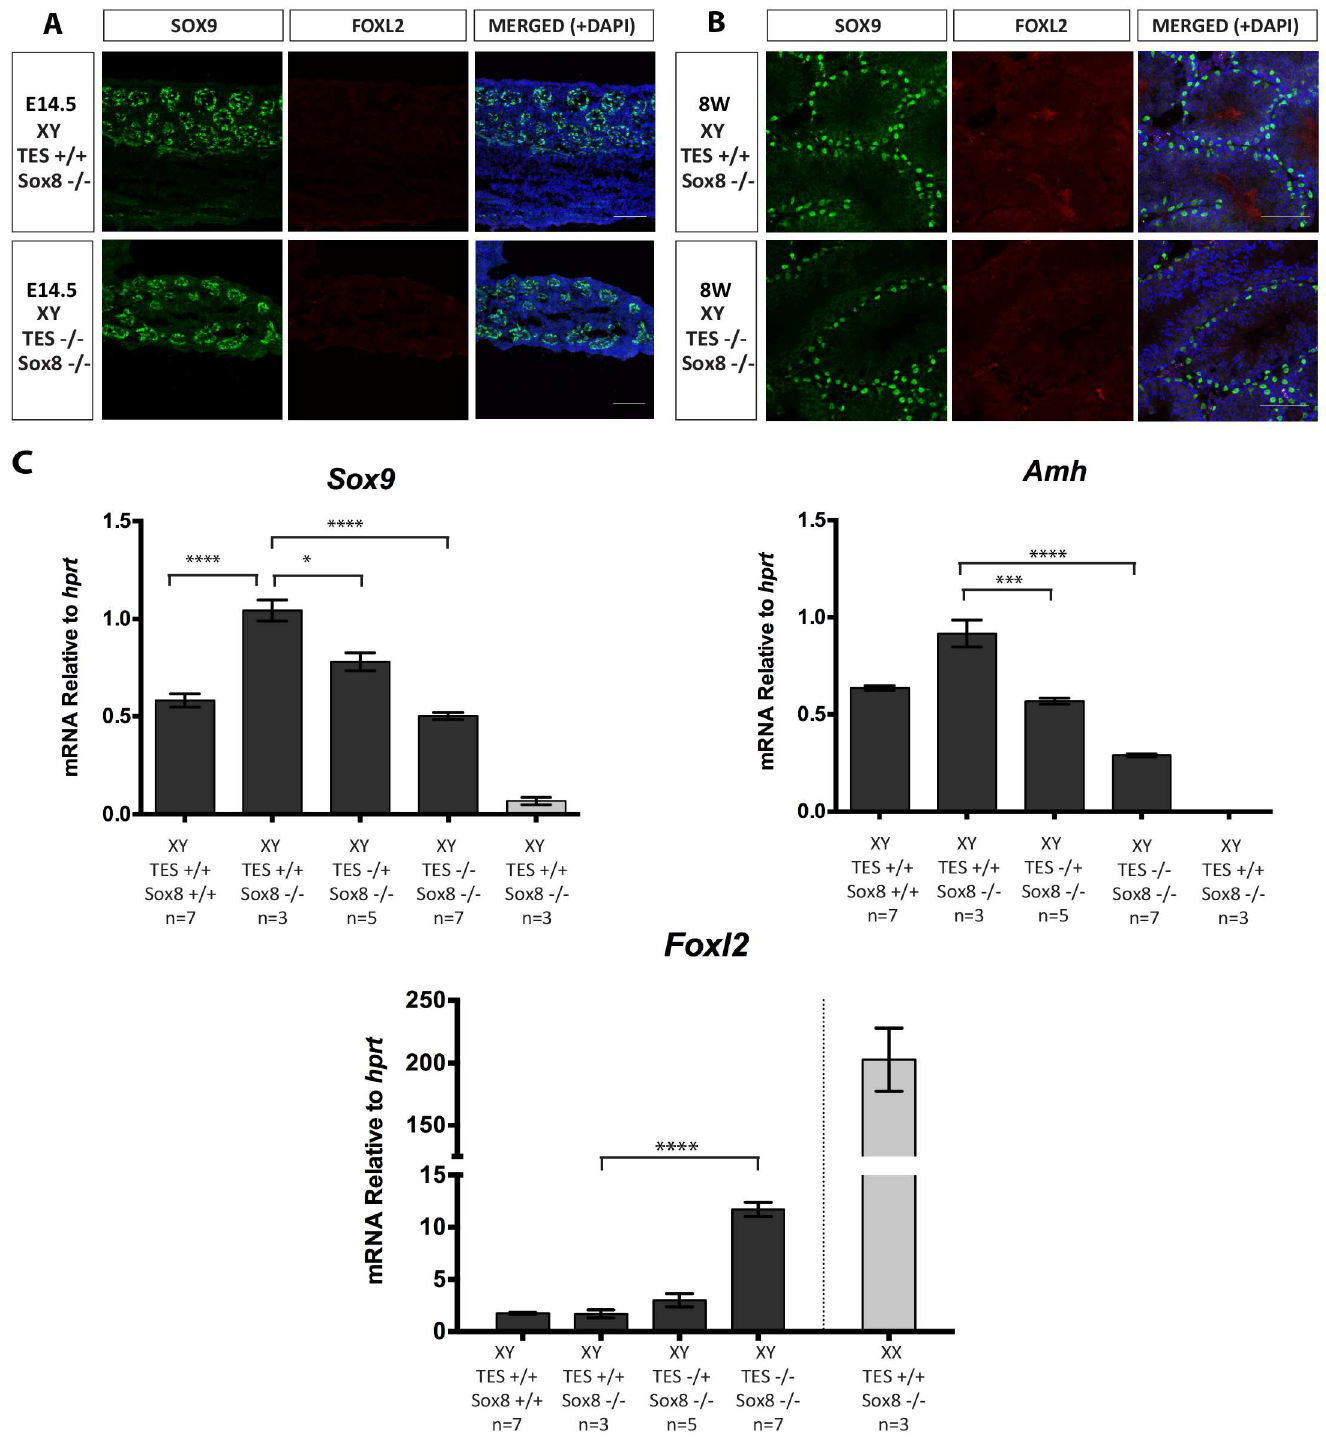
Fig 5. Immunofluorescenceand real-time quantitative RT-PCR analysis of mice carrying TES deletion on Sox8 -null background. (A) Immunostainingof 14.5 dpc XY testis of wild type and TES -/- embryoson a Sox8 -nullbackground. (B) Immunostaining of 8 week-oldXY testes of wild type and TES -/- mice on a Sox8 -null background. Testes were stainedfor SOX9 (green), FOXL2 (red) and DAPI (blue). (C) Gene expressionin XY TES deletedgonadswith Sox8 -null background at 14.5 dpc. Data are presentedas mean 2 - ΔΔ Ct values normalizedto Hprt . Samplesize represents numberof individualsand is indicatedbeloweach genotype. Error bars show SEM of 2 - ΔΔ Ct values. P value is presented abovethe relevant bars (unpaired, two- tailed t-test on 2 - ΔΔ Ct values). Dark grey bars: XY; light grey bars: